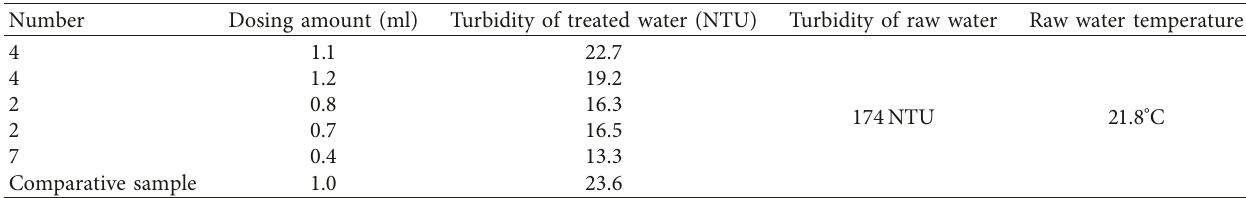
Table 13: Comparison experiment of formula nos. 2, 4, and 7 and contrast